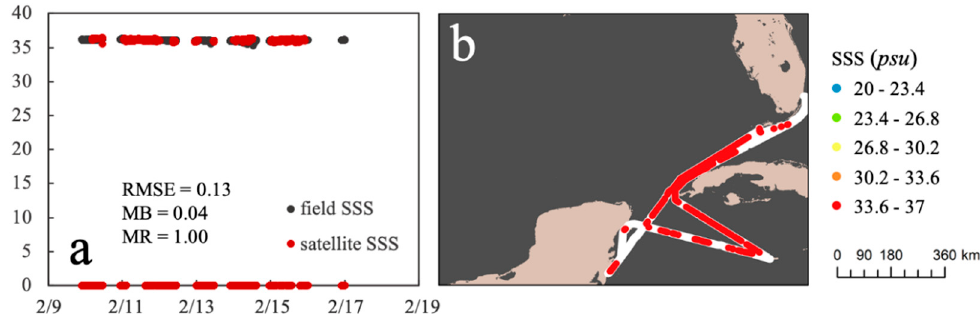
Figure 11. Performance of the SSS model in quantifying SSS in the southeast GOM near the Loop Current. ( a ) Comparison between field-measured SSS and MODIS-derived modeled SSS, the red dots on the X -axis indicate that there are no corresponding MODIS-derived SSS; ( b ) spatial distributions of the MODIS-derived SSS along the cruise track in ( a ), colored by field-measured value, white color indicates no MODIS